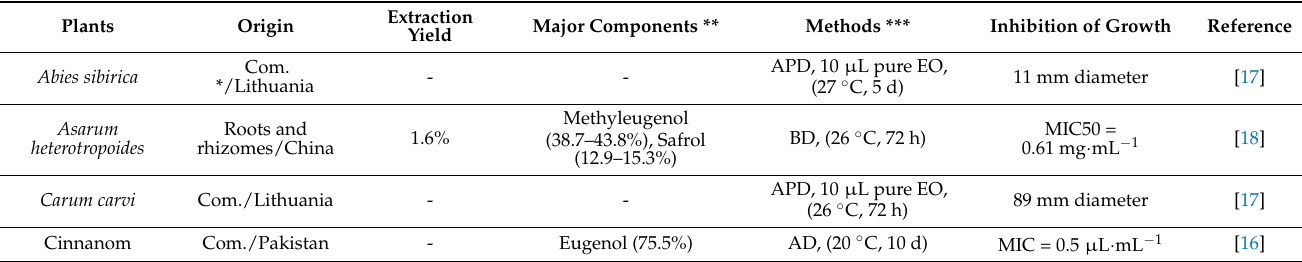
Table 1. Published article with data on the effect of essential oils (EOs) on the mycelial growth of F. avenaceum . Plants Origin Extraction Yield Major Components **